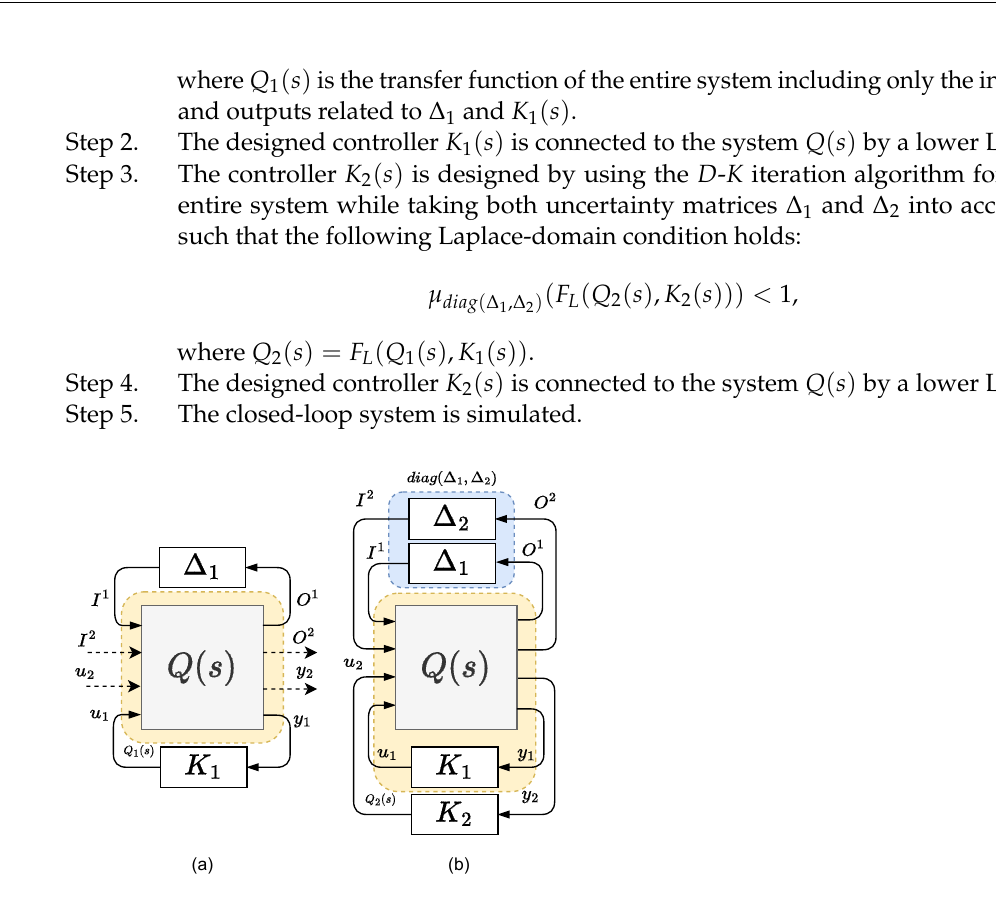
Figure 7. The procedure of the sequential design of the decentralized robust controllers based on the ∆ / Q / K structure: ( a ) design the first controller K 1 , while the second controller K 2 is replaced by open connections, and ( b ) design the second controller K 2 , while the first controller K 1 is designed and in